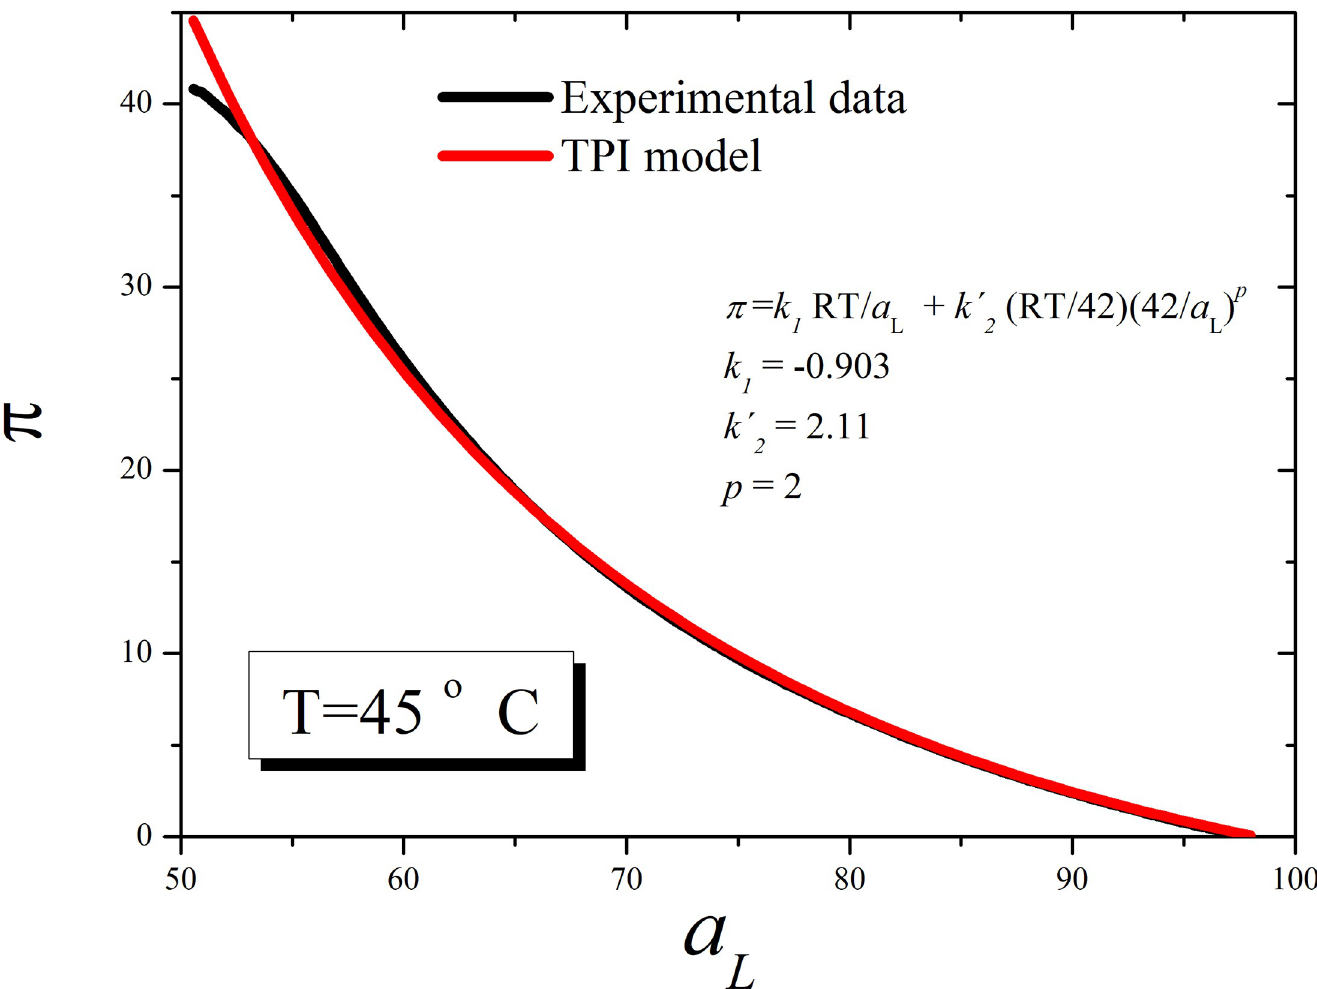
Fig 5. Surface pressures versus area per molecule for the TPI model at 45˚C. Experimental (Black line) and calculated lipid curves for DPPC above the critical point according to Eq (21) at 45˚C for a set of parameters corresponding to membranes.